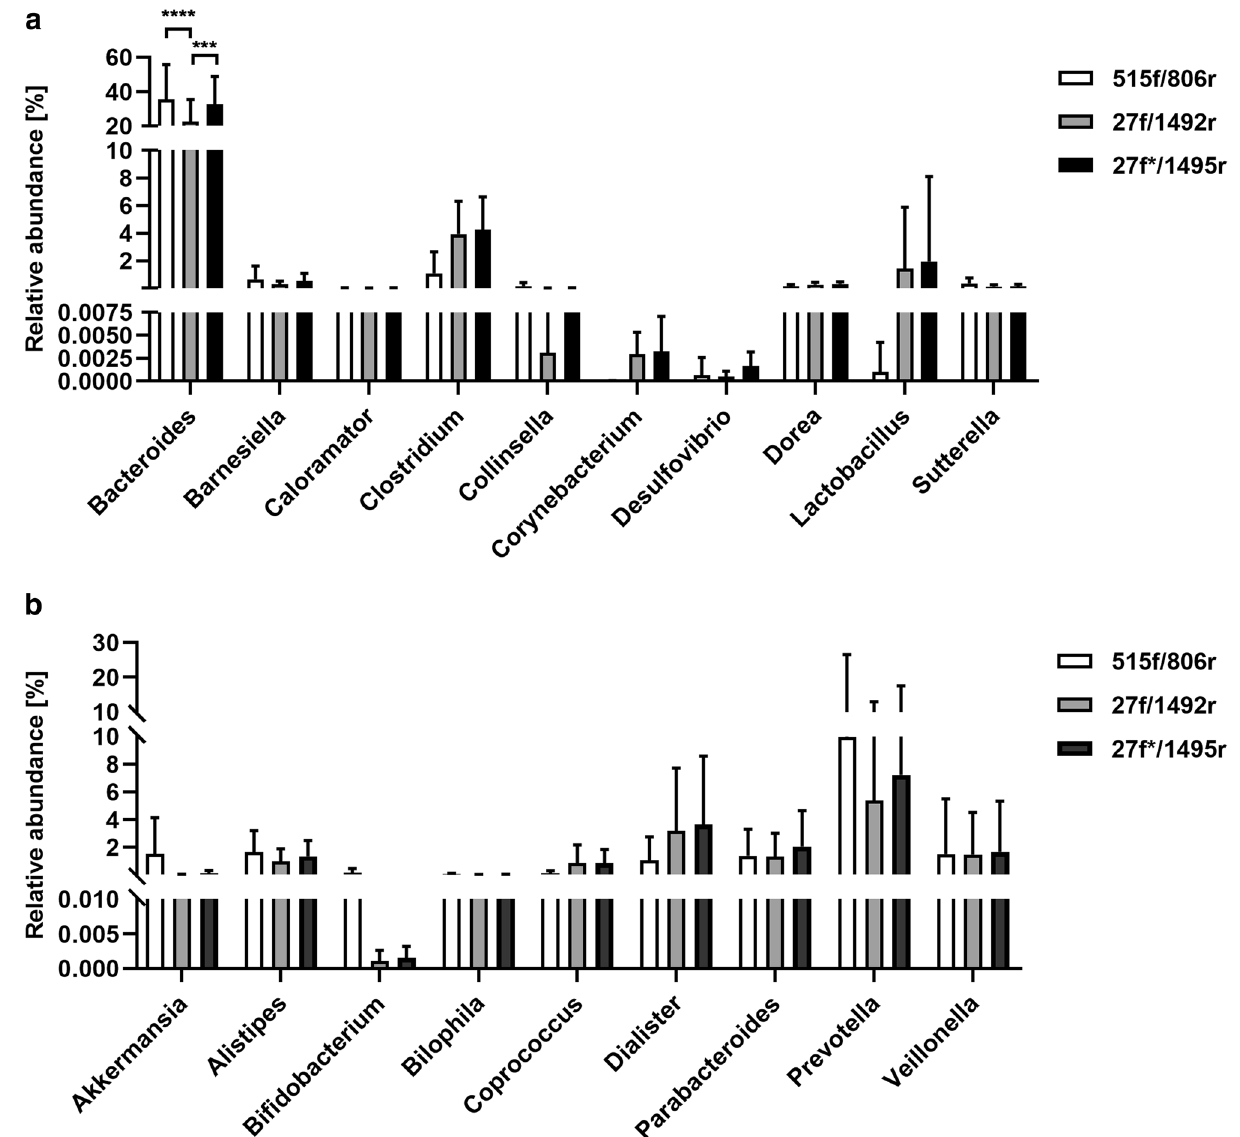
Figure 7. ( a ) Relative abundance of bacterial species that have been observed to be elevated in children with ASD. The level of significance ≤ 0.01 was applied. ( b) Relative abundance of bacterial species that have been observed to be decreased in children with ASD. The level of significance ≤ 0.01 was highly depends on the analysed 16S rRNA region; the 27f/1492r provides approximately 4-times higher F/B ratio than 515f/806r what points to the bottle-neck of this value in any microbiome analysis.